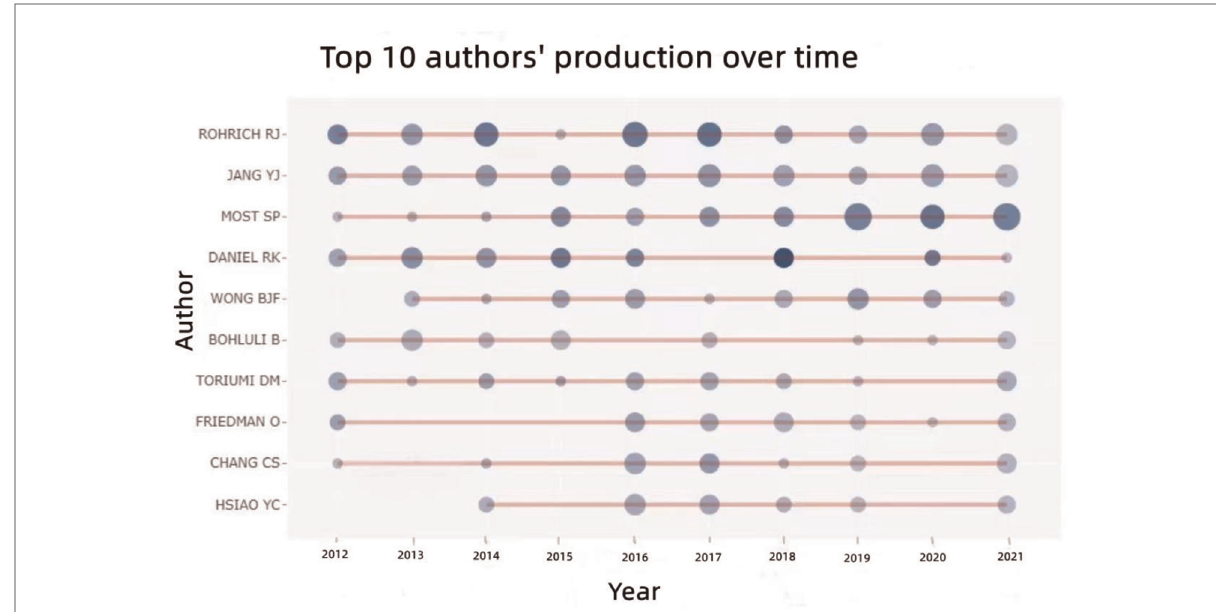
FIGURE 6 The annual output of literature studies by the top 10 authors from 2012 to 2021.